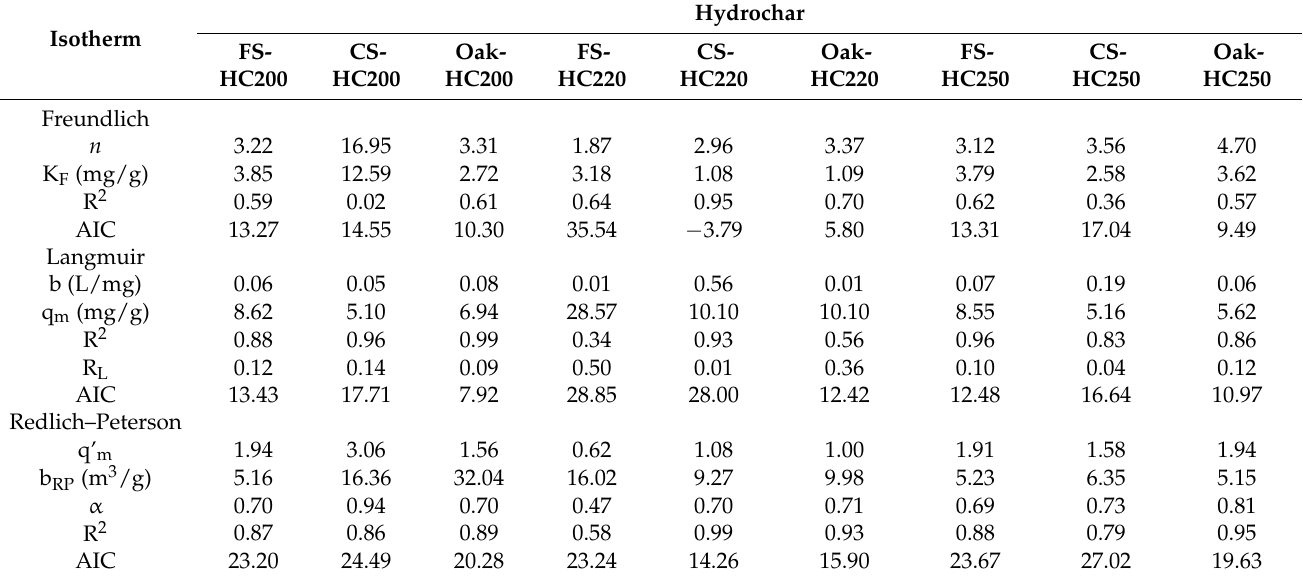
Table 2. Comparison of adsorption isotherm models for MB dye adsorption onto FS-HCs, CS-HCs, and